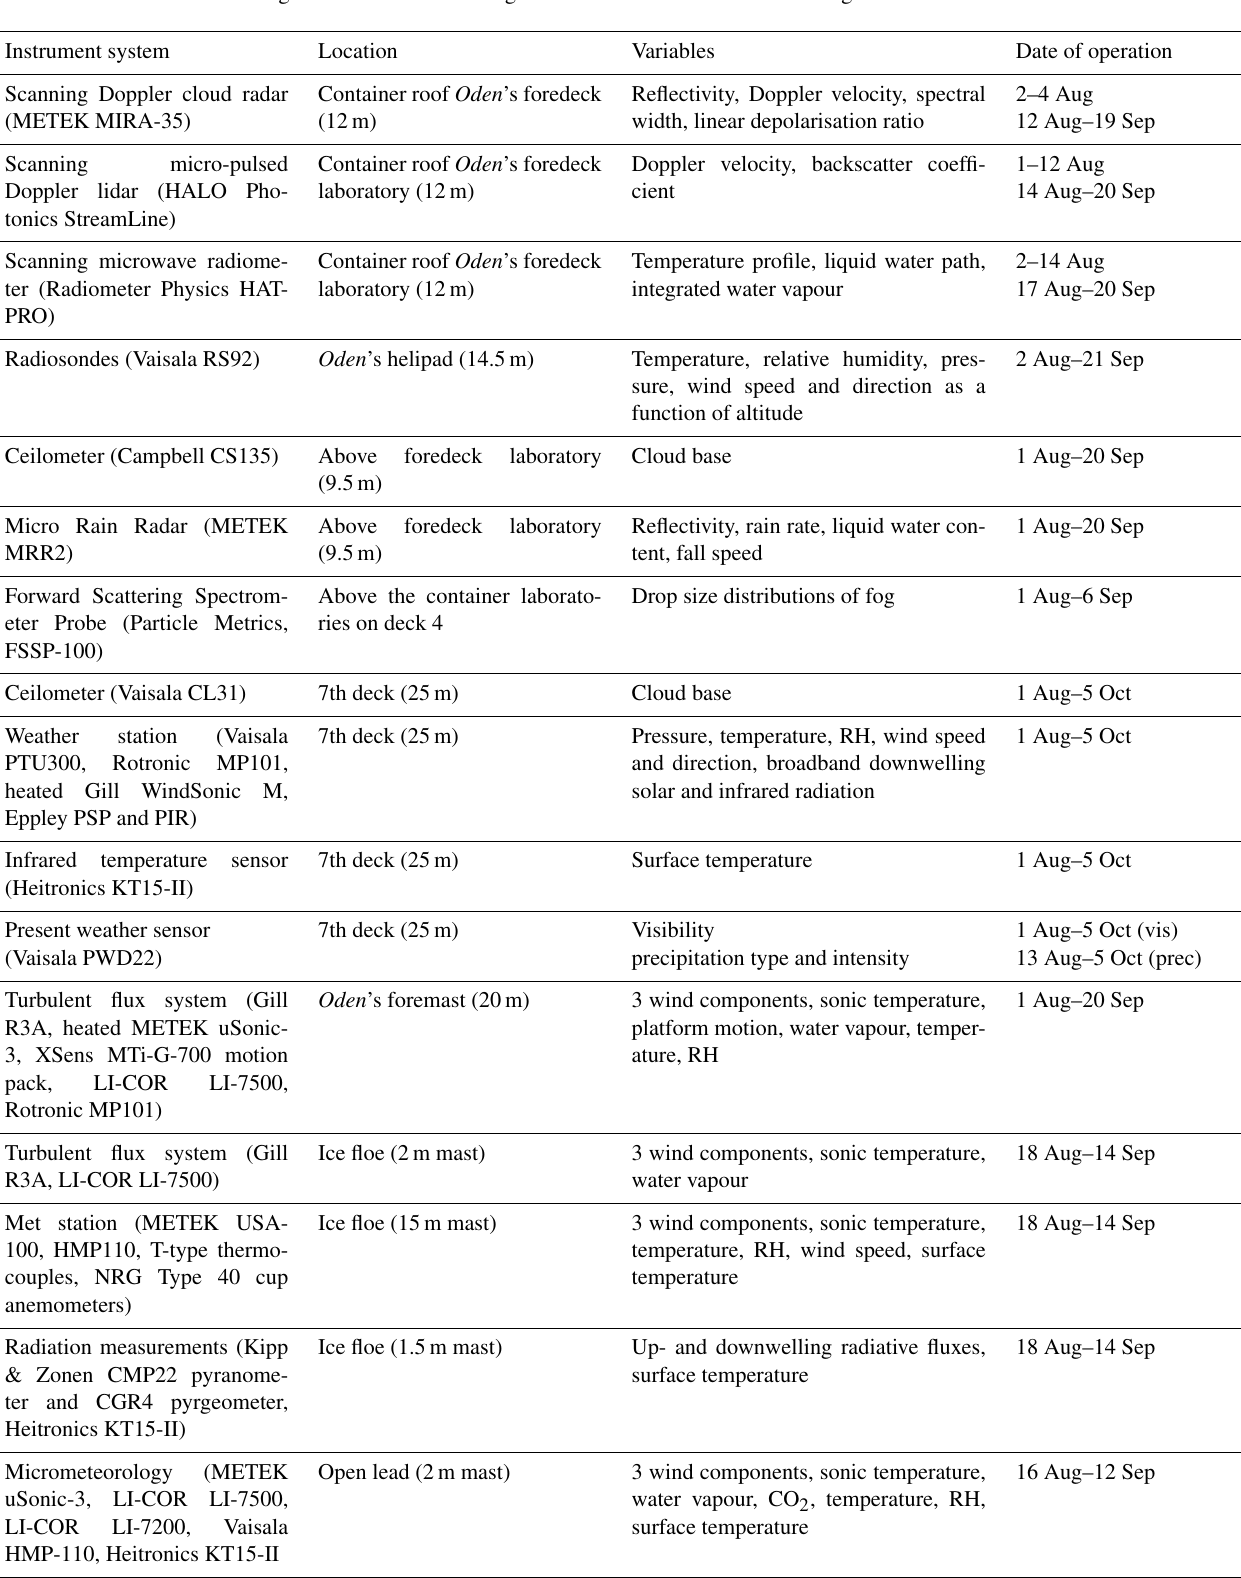
Table 2. Overview of meteorological instruments. All heights for instrumentation on Oden are given relative to the